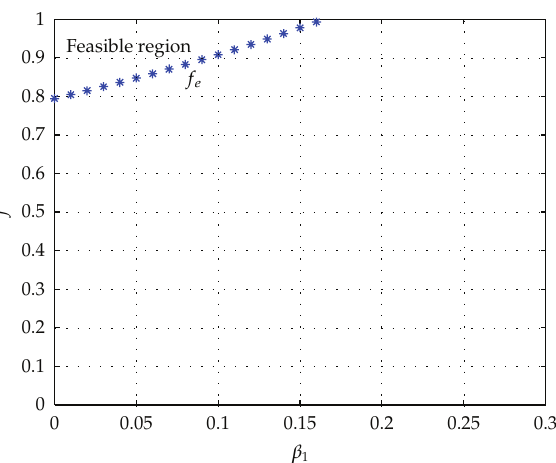
Figure 3: The theoretical immune feasible region f